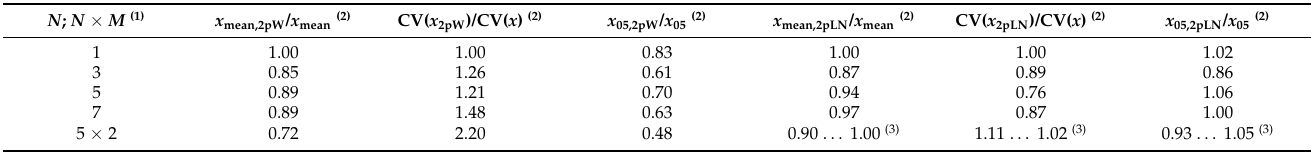
Table 12. Ratios between theoretical values from probabilistic models and empirical statistics assum- ing either a 2pW or a 2pLN distribution